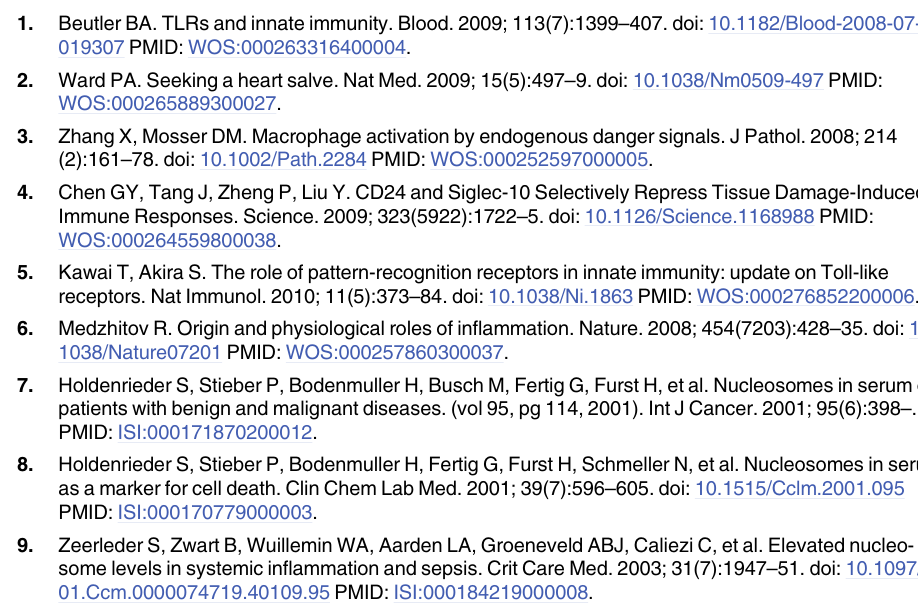
(E) Human neutrophils were incubated with different concentrations of CTHs for 12h at 37°C. CXCL10 levels were measured by ELISA. S2 Fig. Dose response curves of CXCL10 induction by different histone subclasses. Pam3CSK4 (200 ng/ml) or LPS (100 ng/ml) was added to heparinized blood in presence of antibodies against human TLR2 (25 μ g/ml), human TLR4 (25 μ g/ml), or an isotype control (25 μ g/ml). After a 12-hour incubation at 37°C, the release of IL-6 was measured. Blood stimu- lated with CTHs in the absence of an antibody served as control. (TIFF) S3 Fig. LPS levels in recombinant histones. Traces of LPS were measured in different histone subclasses (A) and histone H4-derived synthetic peptides (B) using Pierce LAL Chromogenic Endotoxin Quantitation